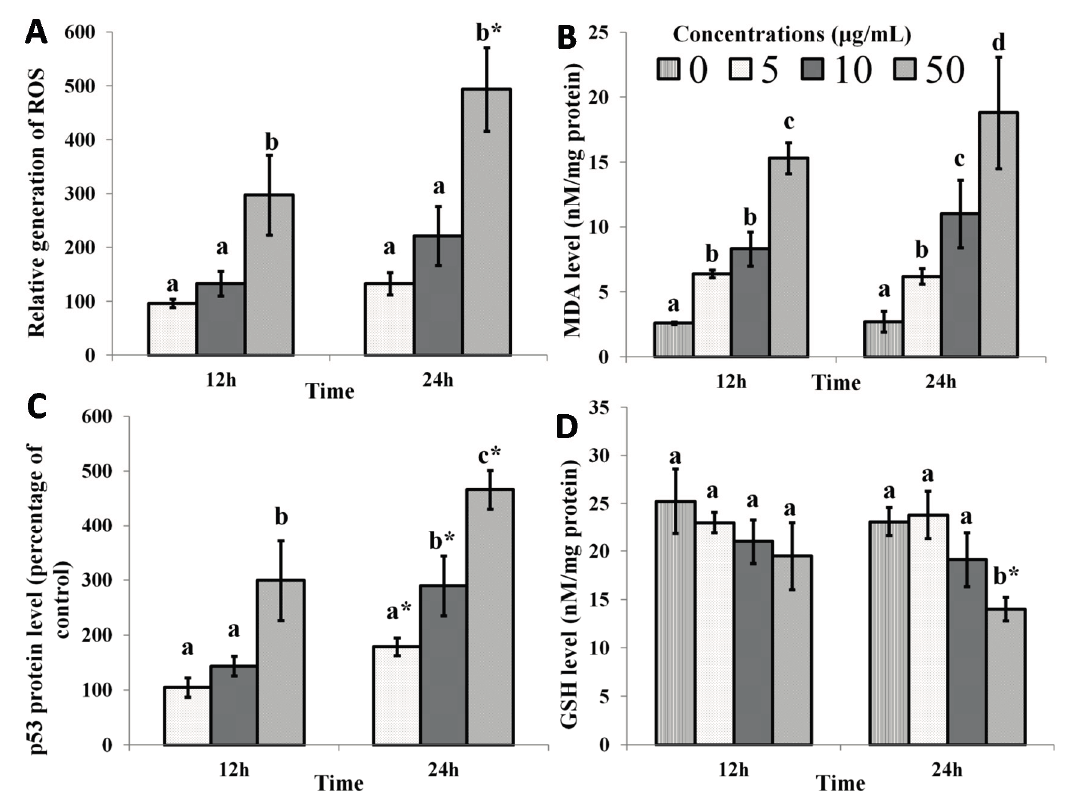
Figure 1. The effect of mango kernel extract on ( A ) the relative generation of reactive oxygen species (ROS) and ( B ) malondialdehyde (MDA) level; ( C ) p53 level and ( D ) Glutathione (GSH) level in MCF-7 cells. Treatment with mango kernel extract produced time- and dose-dependent changes in oxidative stress markers. Bars with different letters for any time period of an assay indicate a significant difference ( p < 0.05). * Significant difference between 12 and 24 h with the same concentrations of